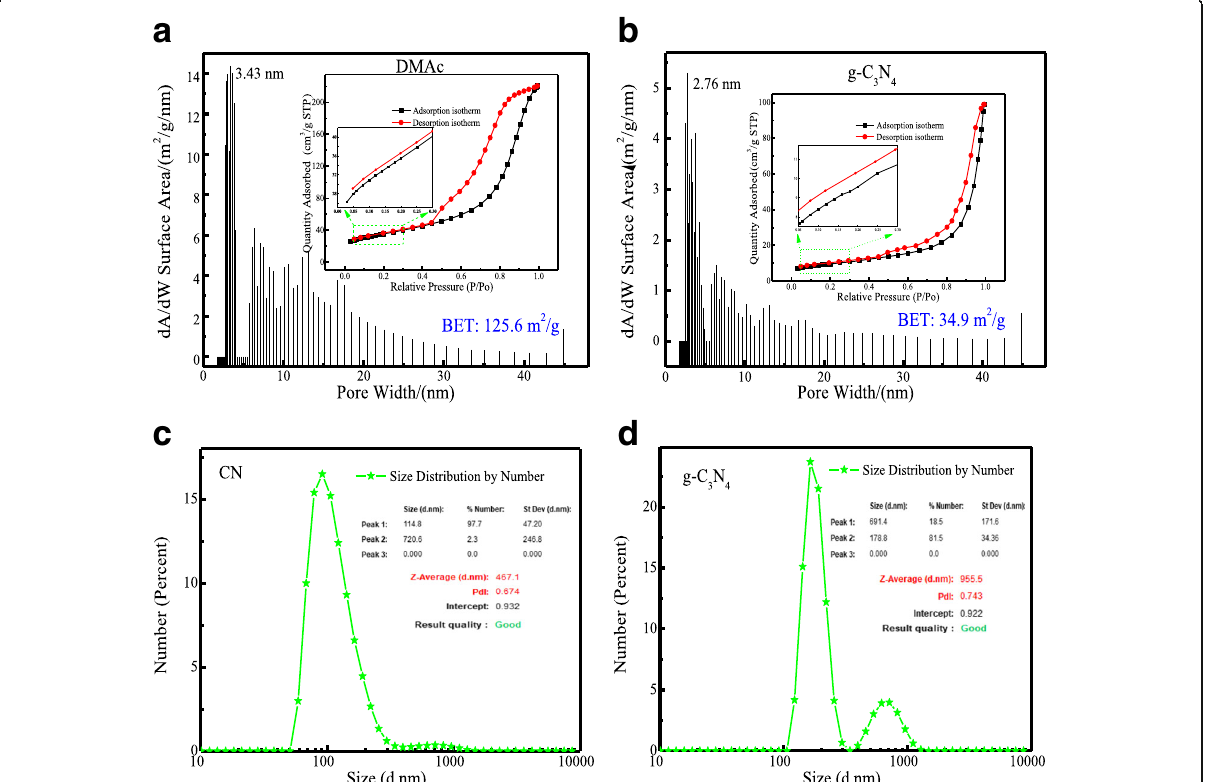
Fig. 3 Pore size distribution of a CN and b g-C 3 N 4 . Inset: N 2 adsorption and desorption isotherm measured at − 195.671 °C and the particle size of c CN and d g-C